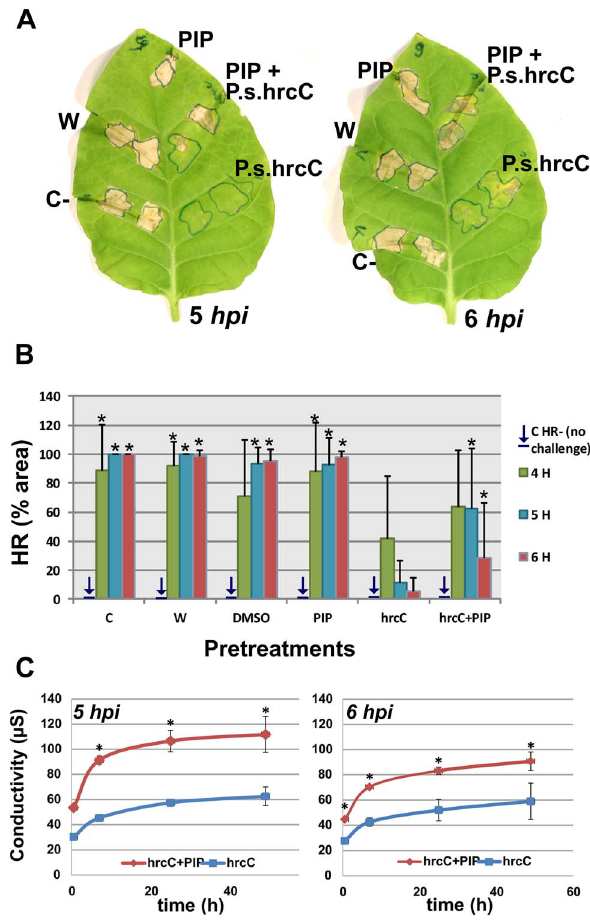
Figure 5. HR-inhibition tests and electrolyte leakage measure- ments to show the ability of PIP to reduce PTI efficiency. A) Representative images showing the difference in the extension of the HR lesion induced by P. syringae 61 challenge inoculation following pretreatment with P. syringae hrcC - bacteria (hrcC), verus pretreatment with PIP + hrcC, and controls. B) Numerical evaluation of the data. Whole intervein areas were pretreated with piperonylic acid (PIP), P. syringae hrcC - bacteria (hrcC), their combination (PIP + hrcC), or as controls: with dimethyl sulfoxide (DMSO), water (W) or left untreated (C). Challenge treatments with P. syringae 61 (HR-inducing wild type) bacteria followed after 4, 5 and 6 hours. The area of the challenge infiltration was circumscribed with a marker pen. The percentage of this area where HR developed, was noted. Values are the average of three independent experiments. Standard deviations are included in the diagram, and stars indicate significant difference (p , 0.05) as compared to the hrcC- treatment. C) Electrolyte leakage measurements to quantify degree of HR development. P. syringae hrcC - bacteria (hrcC) alone or in combination with piperonylic acid (PIP + hrcC) were injected into tobacco leaves. 5 and 6 hours after the pre-treatment, leaves were injected with P. syringae pv. syringae 61 (HR-inducing wild type). Leaf disks were cut out 16 hours later, floated on double distilled H 2 O, and conductivity was measured in a time series. Significant differences between hrcC and PIP + hrcC conductivity values are indicated by stars (p , 0.05).